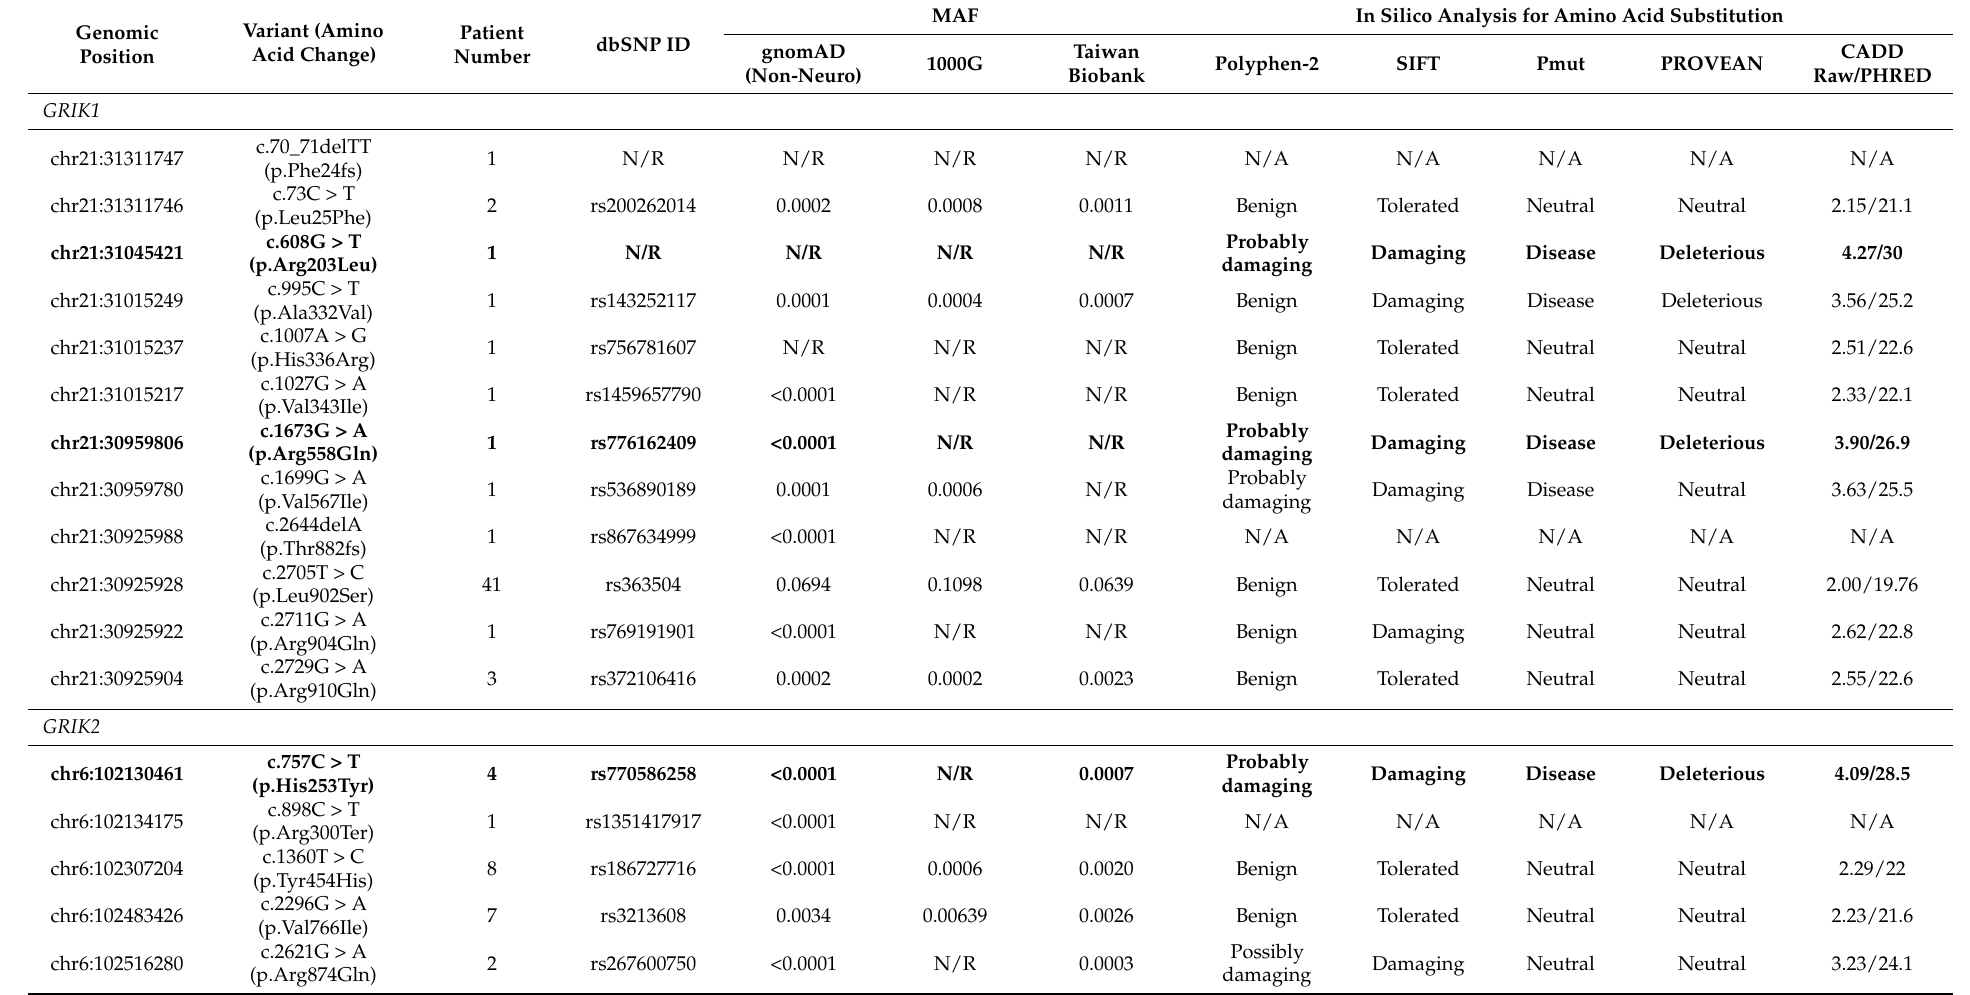
Table 1. Bioinformatic analysis of the protein-altering mutations identified from 516 patients with schizophrenia in the semiconductor sequencing stage. Genomic